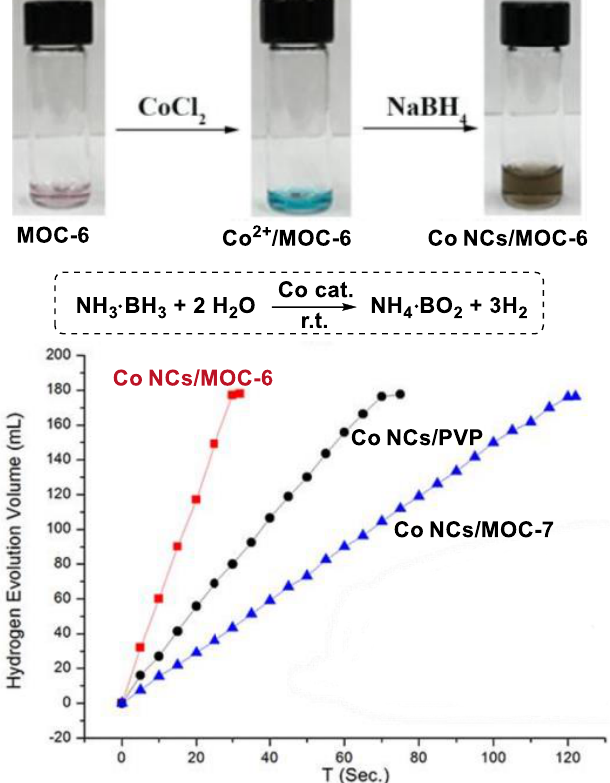
Figure 6. Hydrolysis of ammonium borane catalyzed by Co nanoparticle catalysts [58]. Reaction additions: ammonia borane (1 mmol), H 2 O (1 mL), (Co 0.16 mmol), r.t. Reprinted/adapted with permission from Ref. [58]. Copyright 2018 Wiley VCH.